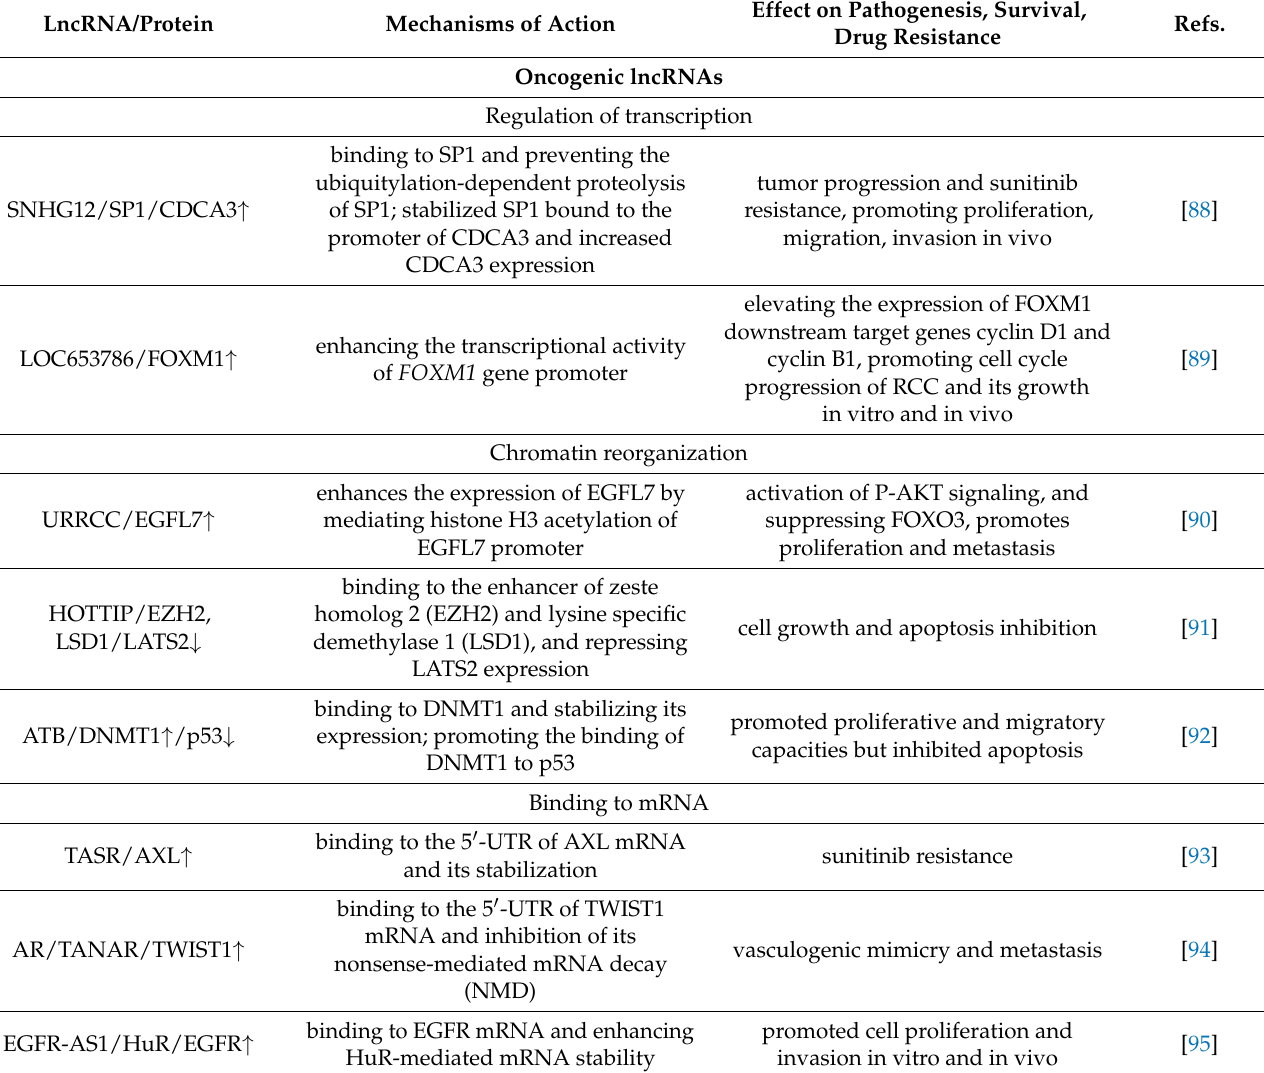
Table 2. Alternative mechanisms of action of lncRNAs in